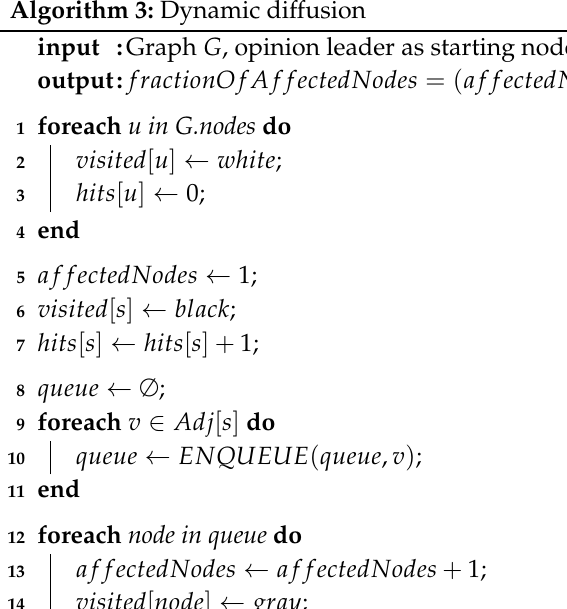
Algorithm 3: Dynamic